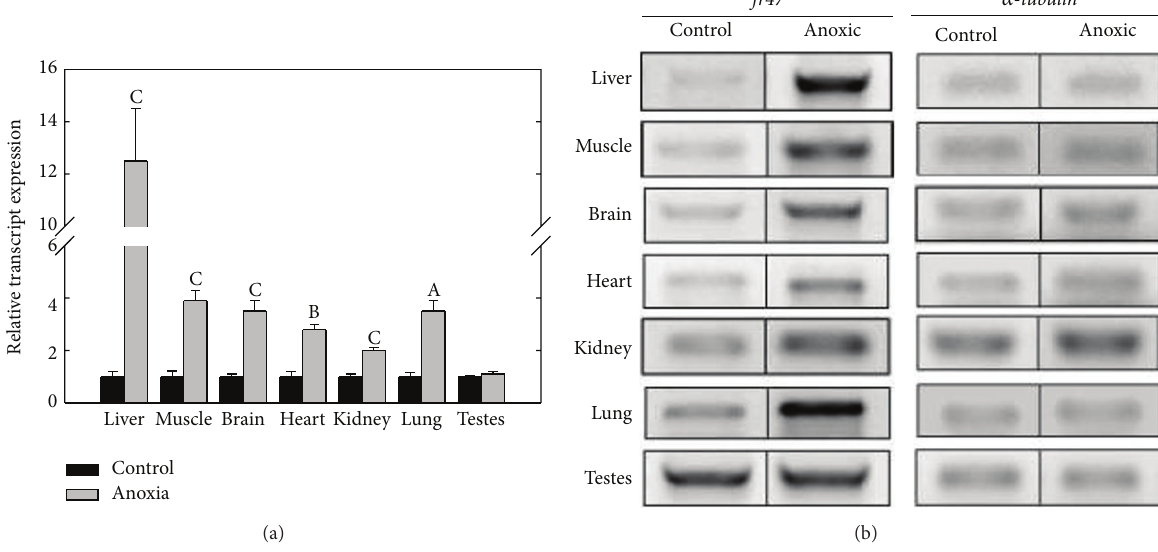
Figure 4: Relative fr47 transcript expression in response to 24 hr of anoxia. RT-PCR analysis showing the effects of 24 hr anoxia exposure on fr47 transcript levels in seven tissues of wood frogs. (a) Histogram shows mean values ( ± SEM, 𝑛 = 4 -5 independent determinations) for fr47 . (b) Representative fr47 and 𝛼 - tubulin bands used for quantification. Other information as in Figure